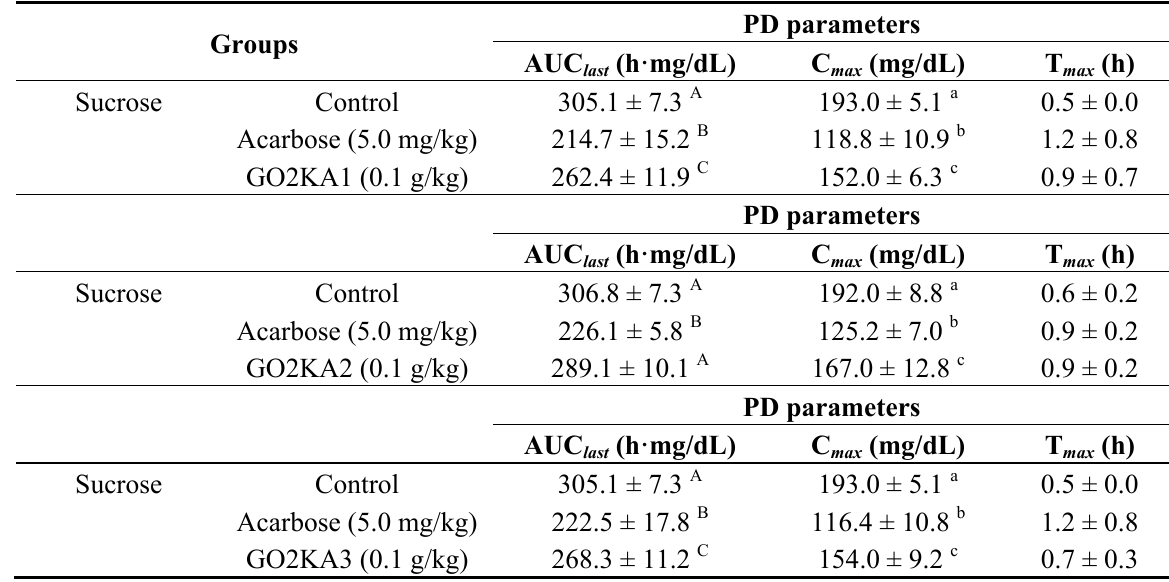
Table 1. Pharmacodynamic (PD) parameters of SD control rats or after administration